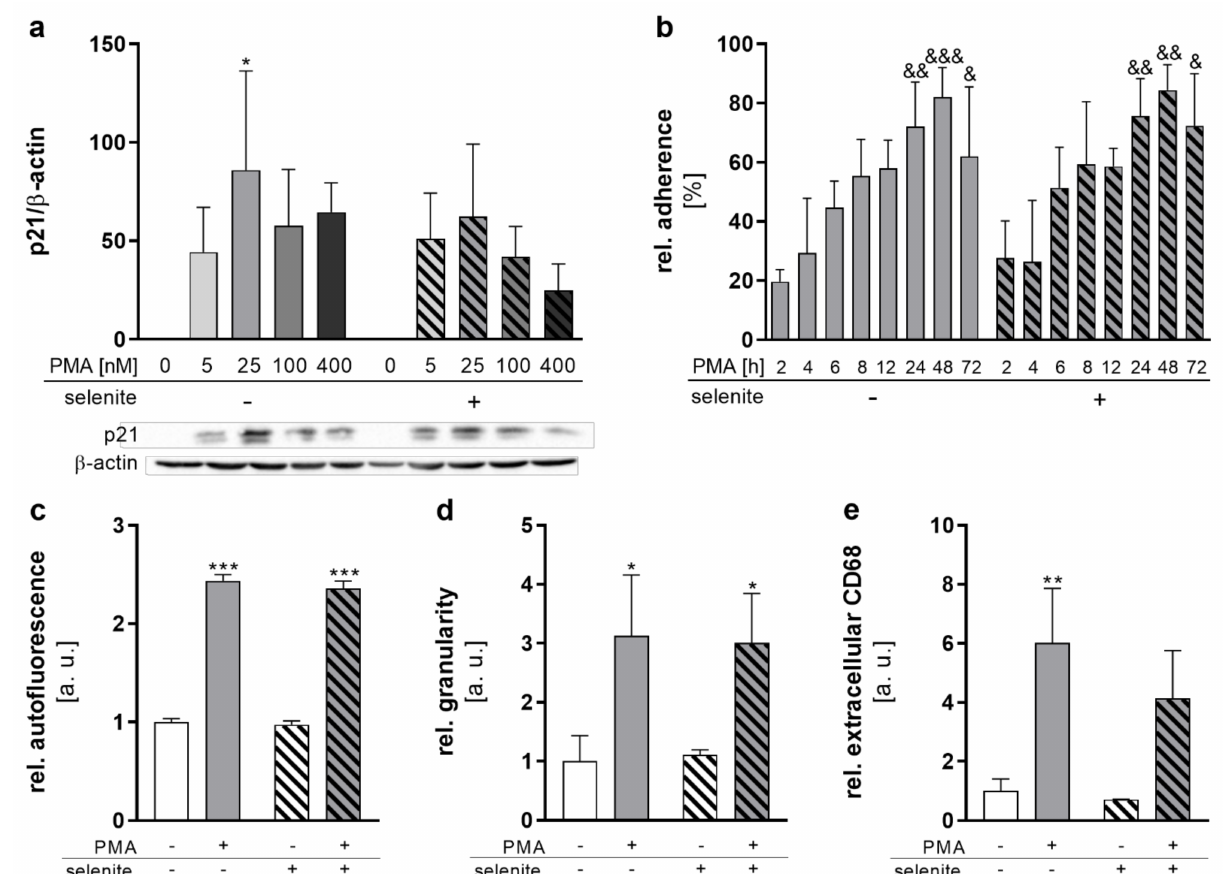
Figure 1. Selenium does not affect differentiation. THP-1 monocytes were pre-treated for 72 h with or without 50 nM sodium selenite (selenite) and differentiated into macrophages by 25 nM PMA or the indicated concentration with or without 50 nM selenite for the indicated time points ( b ) or for 48 h ( a , c – e ). ( a ) Protein expression of p21 was normalized to β -actin. -PMA/-selenite samples were set to 1. A representative blot is shown. ( b ) The relative adherence was calculated as (number of adherent cells/total number of cells) × 100. ( c – e ) The autofluorescence ( c ), intracellular granularity ( d ), and extracellular CD68 ( e ) were determined using flow cytometry. Data are given as means + SD (n = 3–4). Two-way ANOVA with Bonferroni’s post-test. Significant outliers were determined by Grubbs’ test ( α = 0.05). * p < 0.05, ** p < 0.01, *** p < 0.001 vs. cells without PMA (PMA effect); & p < 0.05, && p < 0.01, &&& p < 0.001 vs. 2 h